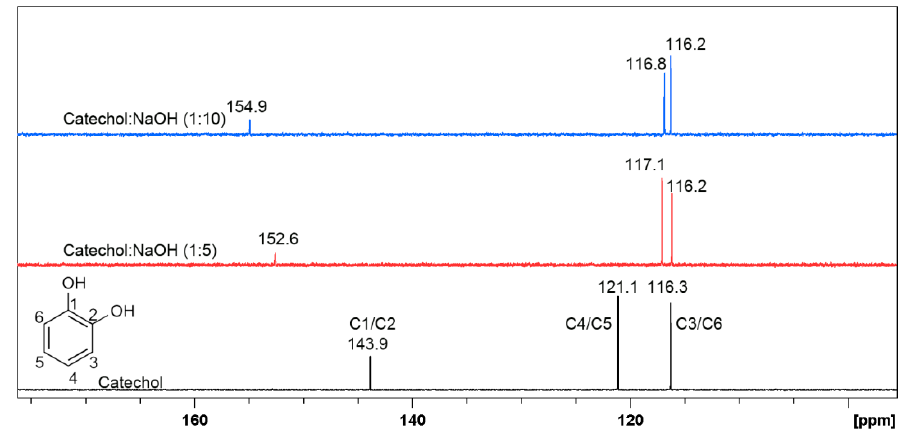
Figure 11. 13 C-NMR spectra of catechol in D 2 O (black line) and in the presence of NaOH in D 2 O in the molar ratio 1:5 (red line) and 1:1 (blue line), respectively.